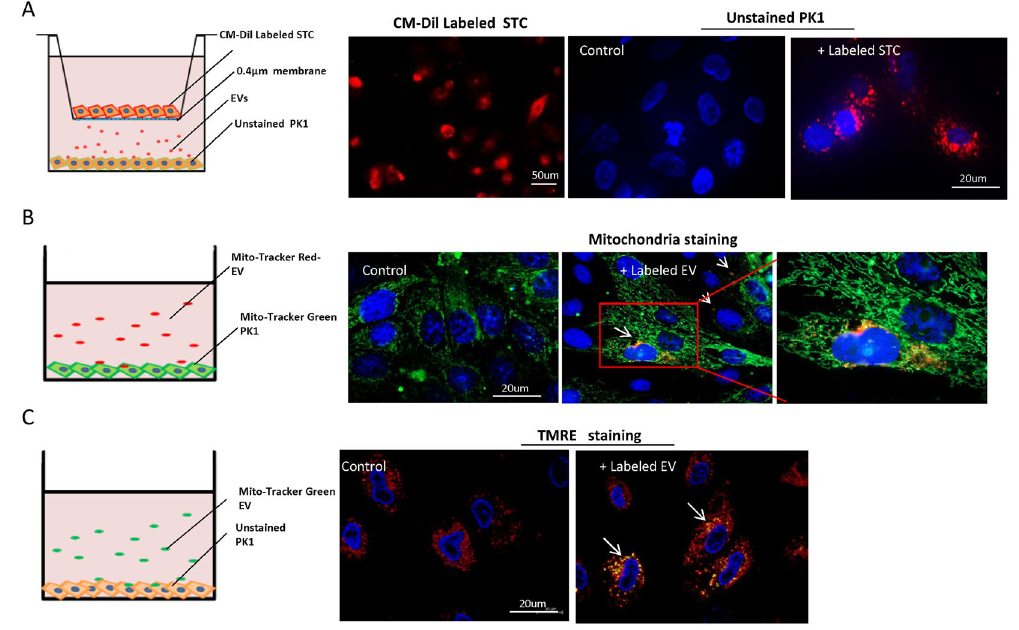
Figure 4. Delivery of mitochondria to tubular epithelial cells (TEC) through extracellular vesicles (EV). ( A ) STC-like cells labeled with red cellular membrane dye were co-cultured with un-labeled PK1 in a non- contact setting. Red signals were subsequently observed in unlabeled PK1 24 h after incubation, and unlabeled STC-like cells were used as control. ( B ) Isolated EV were labeled with Mito-Tracker red. After co-culture with Mito-Tracker green labeled TEC for 24 h, red and yellow staining was found in un-labeled PK1(white arrow). Unlabeled EV were used as control. ( C ) Mitotracker green labeled EV were incubated with PK1 for 24 hours. TMRE staining showed that transferred mitochondria were also stained (white arrow), suggesting maintained activity in injured